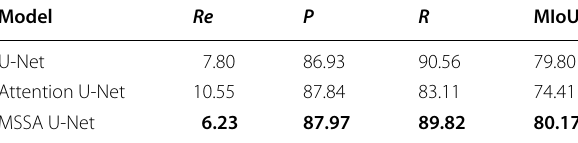
Bold values indicate that the detection accuracy of the proposed method is significantly better than that of other